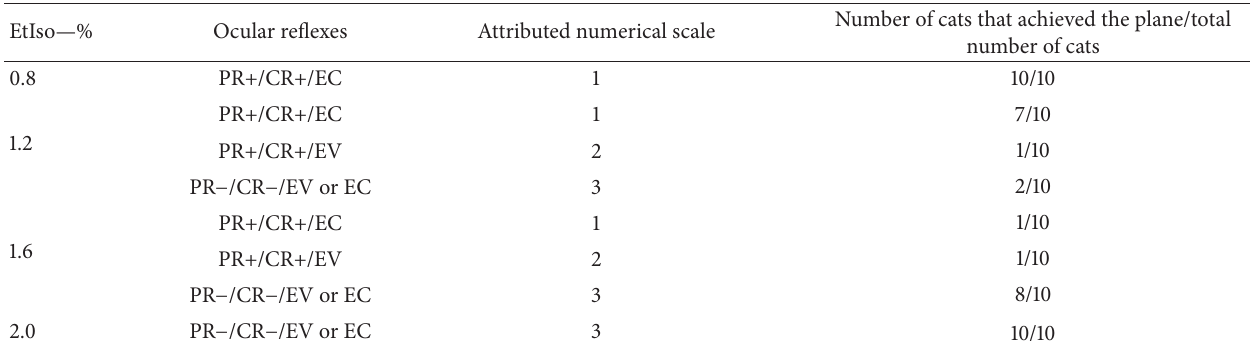
Table 3: Number of cats that achieved each anaesthetic plane for each end-tidal isoflurane (EtIso—%) concentration studied. EtIso—% Ocular reflexes Attributed numerical scale